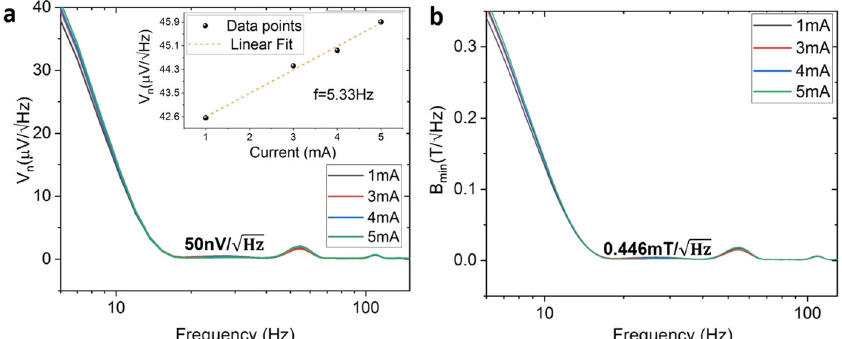
Fig. 5 Noise and resolution of the LSG Hall sensors. a Voltage noise density, V n , and b magnetic resolution, B min , as a function of frequency.